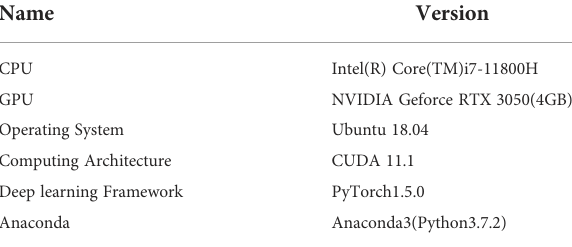
TABLE 1 Image processing unit host hardware and software